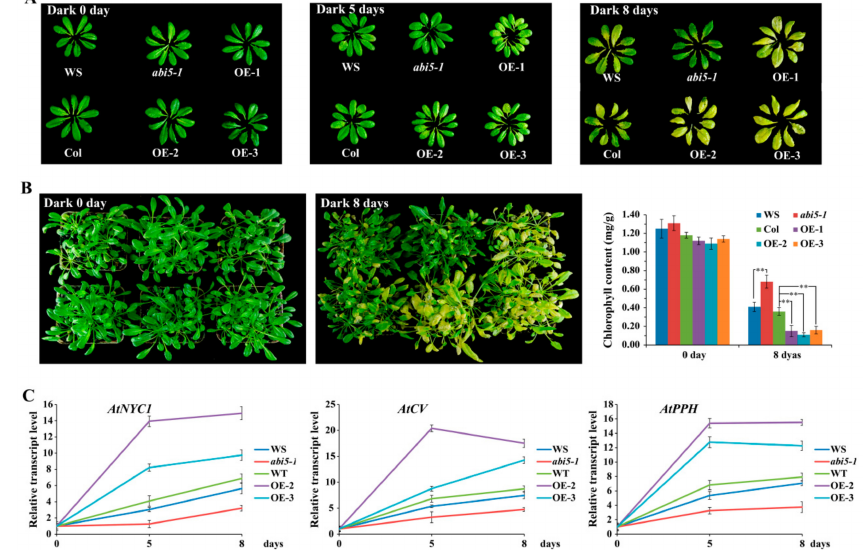
Figure 1. AtABI5 regulates chlorophyll catabolism in Arabidopsis . ( A ) Phenotype of the abi5-1 mutant and overexpressed AtABI5 (OE) transgenic Arabidopsis leaves after 0, 5, and 8 days of dark treatment, respectively. ( B ) Phenotype and chlorophyll content of the abi5-1 mutant and overexpressed AtABI5 (OE) transgenic lines after 0 and 8 days of dark treatment, respectively. The data represent the mean ± SD of 3 independent experiments. Asterisks denote Student’s t-test significant di ff erences as compared with Col (** P < 0.01). ( C ) Transcription levels of chlorophyll catabolism-related genes in Arabidopsis after dark treatment. The data represents the mean ± SD of 3 independent